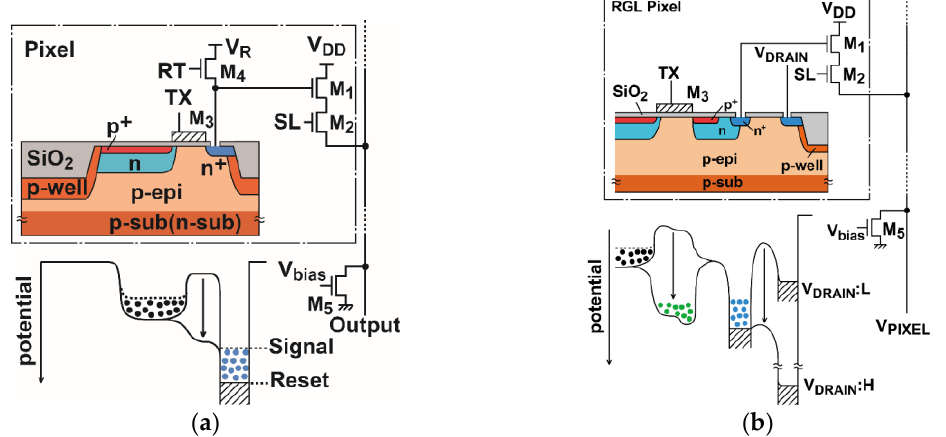
Figure 1. High conversion gain pixels. ( a ) 4T pixel with a pinned photodiode; and ( b ) an RGL high conversion gain pixel.